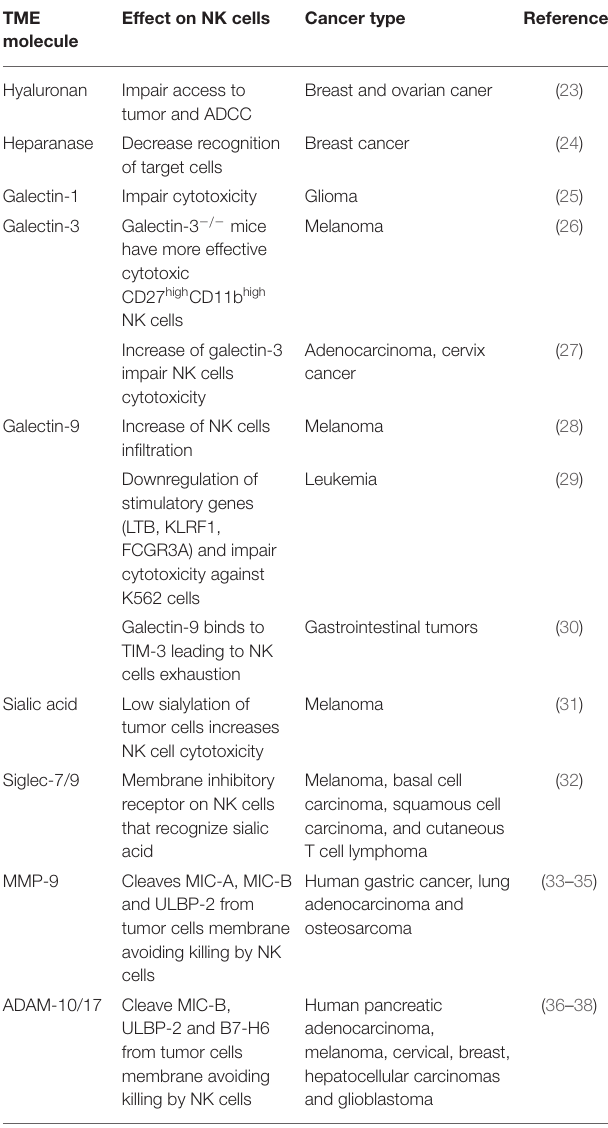
TABLE 1 | TME molecules and the effect on NK